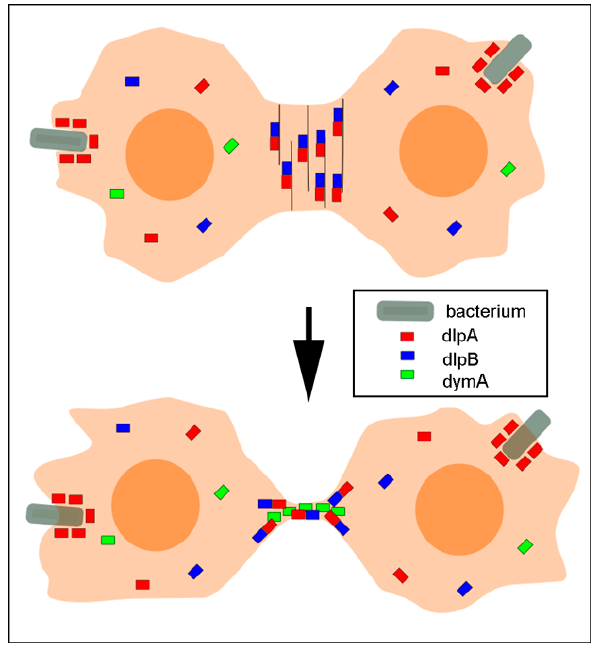
Figure 8. A summary of the localization of three dynamins. Dynamics of dlpA (red small bars), dlpB (blue small bars), and dymA (green small bars) during cytokinesis are shown. DlpA and dlpB form hetero-oligomers and associate with the actin filaments in the contractile ring. DlpA also localizes at the phagocytic cup surrounding a bacterium (gray bars) independently of dlpB. DymA localizes at the intercellular bridge between the daughter cells.